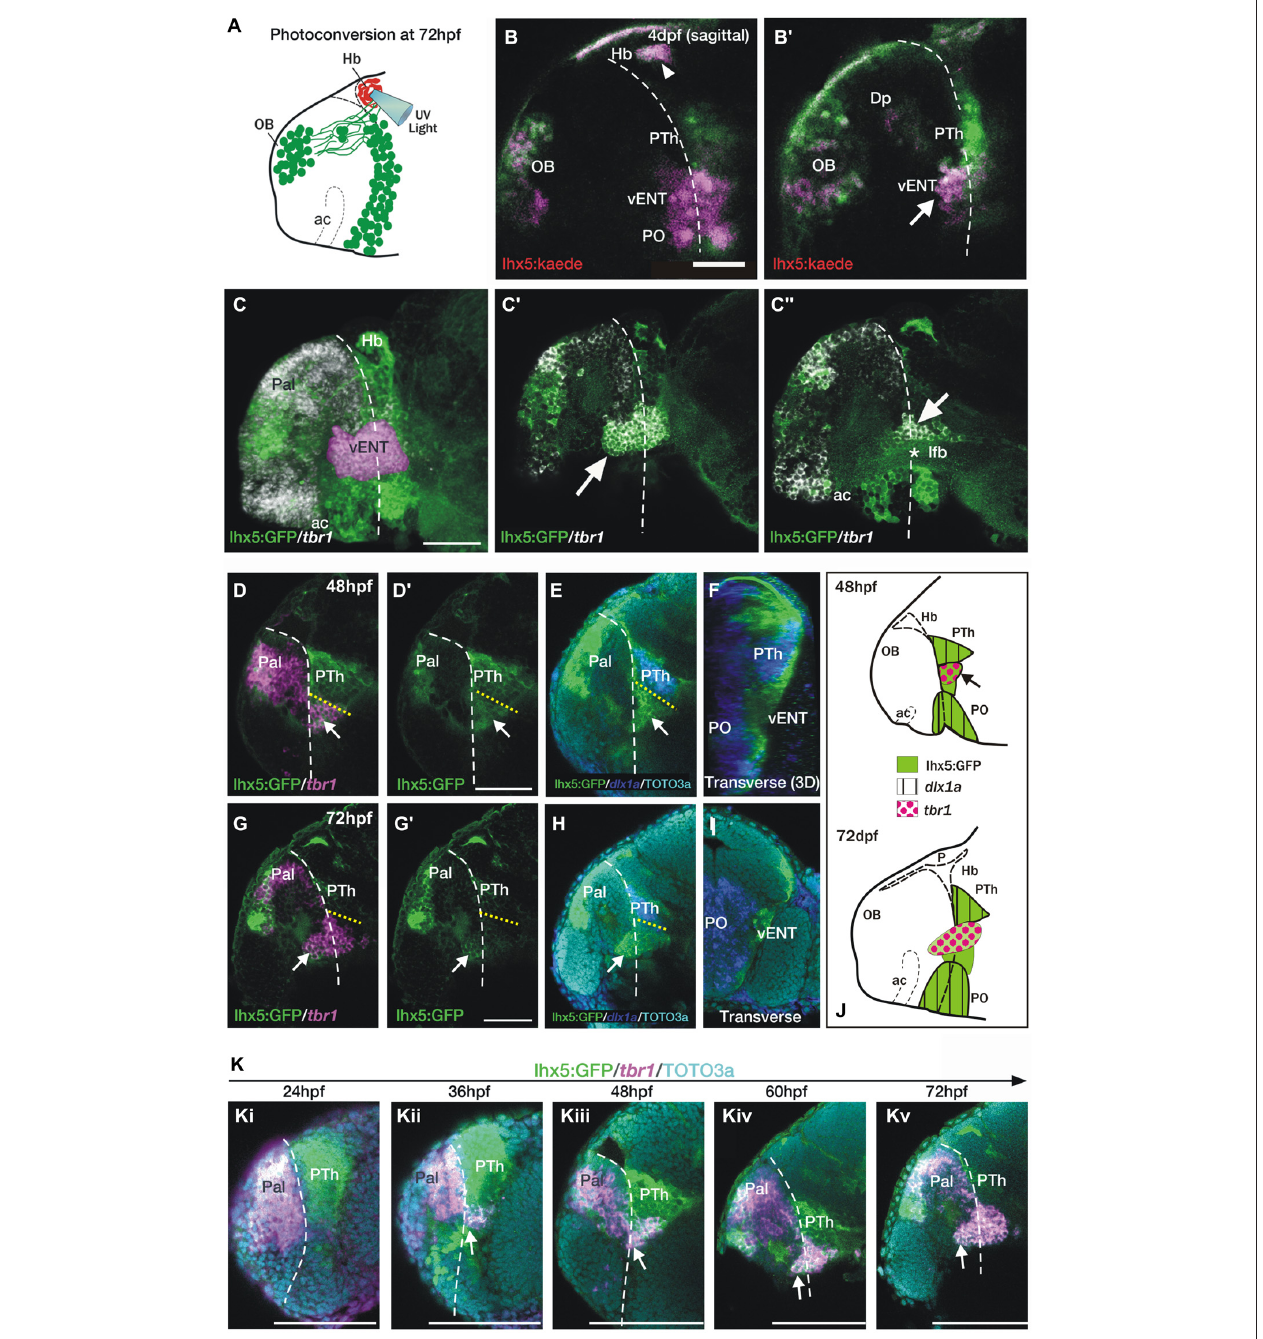
FIGURE 6 | The telencephalic vENT is a major source of habenula afferents, is diencephalic in origin and originates from the prethalamic eminence. The vENT projects to the habenula. (A) Schematic summarizing experimental setup. Habenula neuropil of 72 hpf Tg(lhx5:Kaede) b1204 was photoconverted with a cone of UV light. Photoconversion was made with a lateral approach in order to avoid conversion of areas ventral to the habenula. (B,B (cid:48) ) Lateral views of single Z -slices of Tg (lhx5:Kaede) b1204 larvae ( B (cid:48) is closer to the midline) imaged at 4dpf after photoconversion of the habenula neuropil at 72 hpf. Dotted line marks the anterior intraencephalic sulcus. Some red Kaede cells (magenta in the figure) are observed in the olfactory bulb (OB) and preoptic region (PO), and a few fibers in Dp. A number of red Kaede cells were observed in the domain identified as presumptive larval vENT (arrow in B (cid:48) ). Note red Kaede fibers at the photoconversion area in the habenula (arrowhead in B ). The vENT expresses tbr1 and straddles the telencephalic/diencephalic boundary at 4dpf. (C–C (cid:48)(cid:48) ) Lateral views of Tg(lhx5:GFP) b1205 inmunostaining against GFP (green) and FISH against tbr1 (grayscale). In C , the vENT has been false colored in pink. Dotted lines on lateral views mark the anterior intraencephalic sulcus, which runs from the optic recess at the base of the optic stalks ventrally to the pallial/diencephalic boundary dorsally. (C) 3D projection